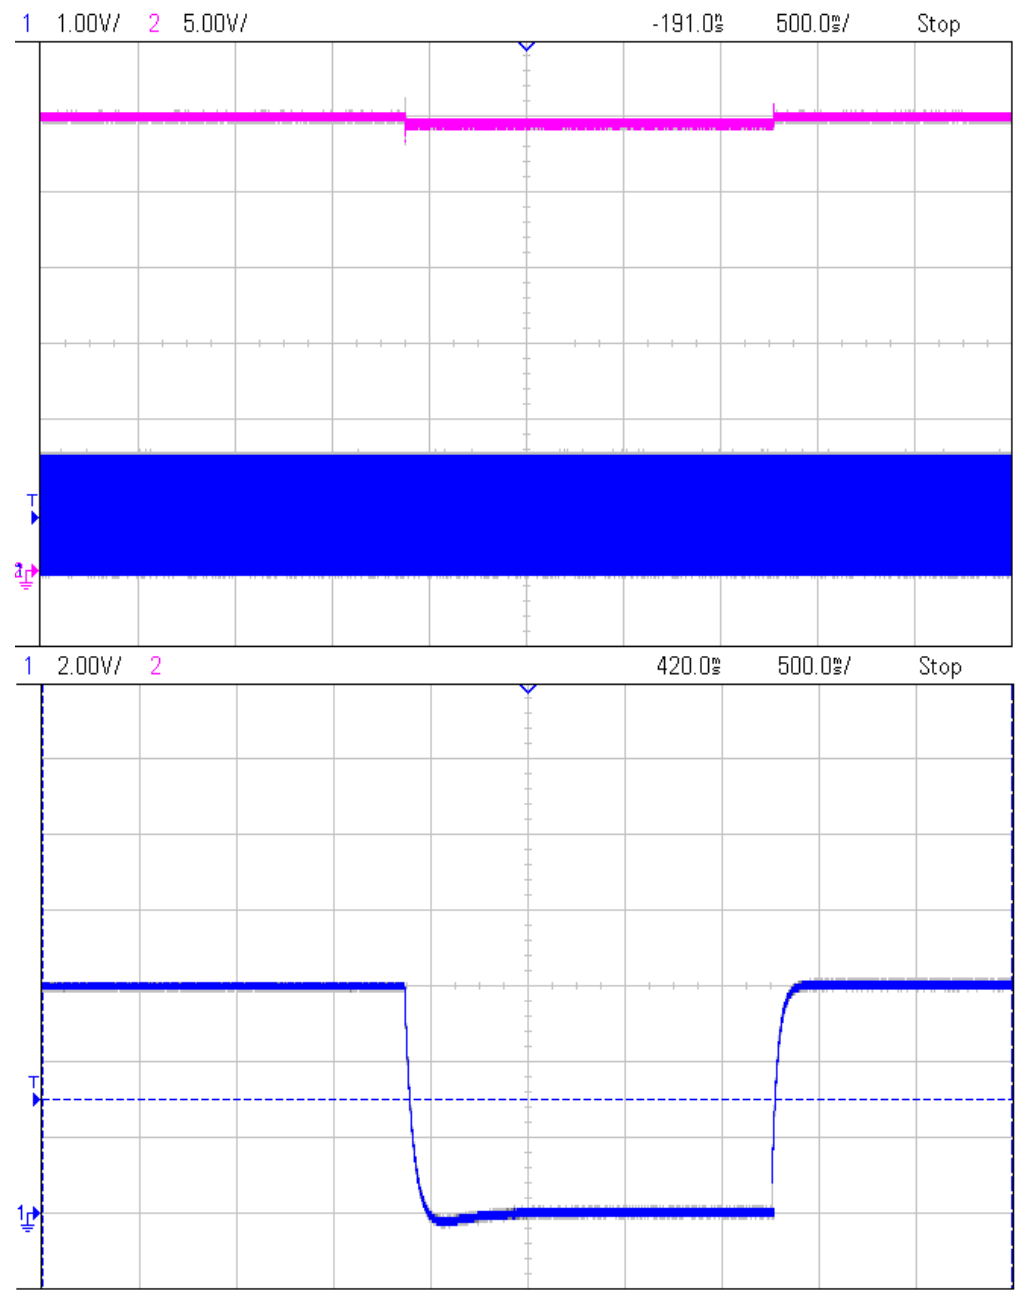
Figure 11. Experimental behavior for PI closed-loop, with failure events in e 1 . Output voltage (upper plot), PWM (middle plot), and e 1 (bottom plot)